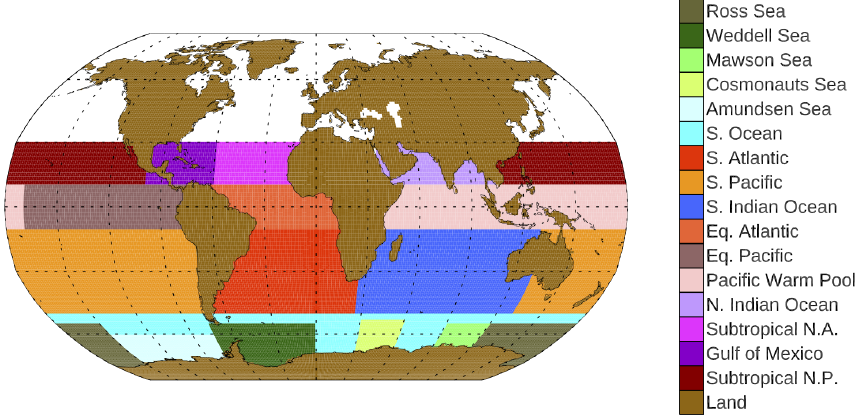
Figure 2. Tagged water source regions that are potentially important for Antarctic precipitation, including all major tropical and subtropical and midlatitude ocean basins (subtropical North Pacific, subtropical North Atlantic, Gulf of Mexico, Indo-Pacific Warm Pool, equatorial Pacific, equatorial Atlantic, northern Indian Ocean, southern Indian Ocean, South Pacific, South Atlantic and Southern Ocean), five finer sectors (Amundsen Sea, Cosmonauts Sea, Mawson Sea, Weddell Sea and Ross Sea) in the Southern Ocean and land (all continents). All remaining oceanic areas (white) are also tagged.